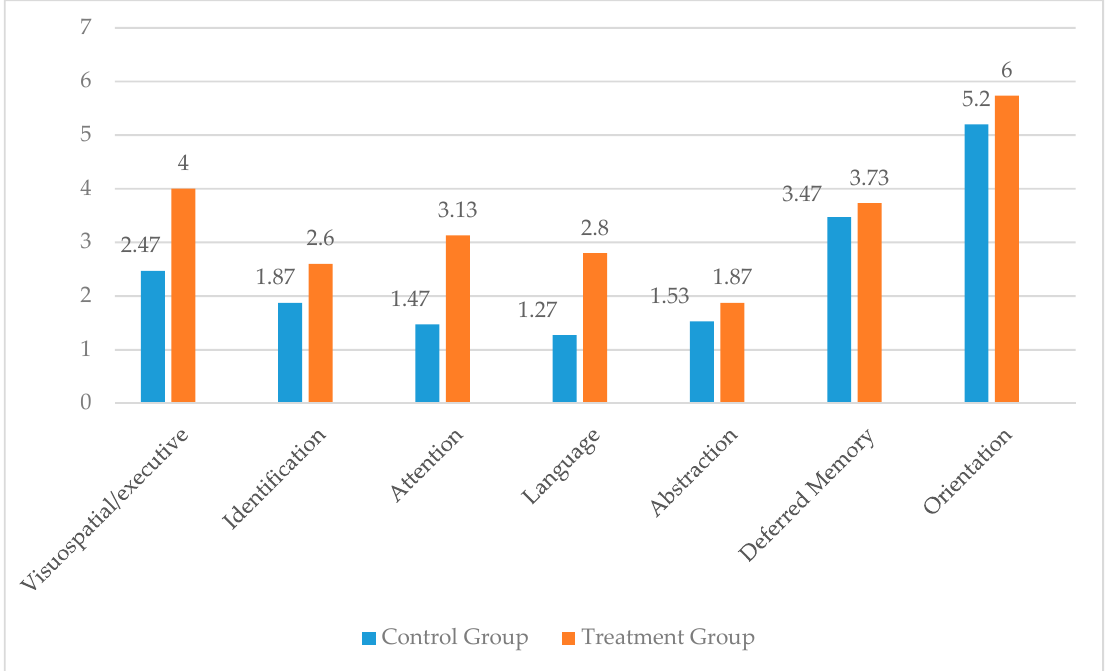
Figure 2. Effect of training in the different areas evaluated by MoCA in the treatment group Figure 2. E ff ect of training in the di ff erent areas evaluated by MoCA in the treatment group compared compared to the control group. to the control